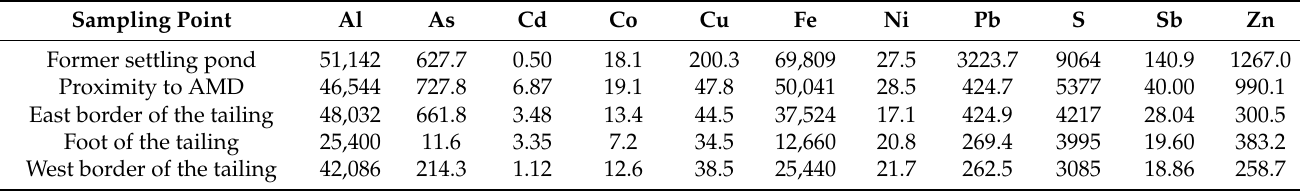
Table 3. Metal concentrations ( µ g.g − 1 ) in constitutive materials of the tailing according to the different sampling points. Sampling